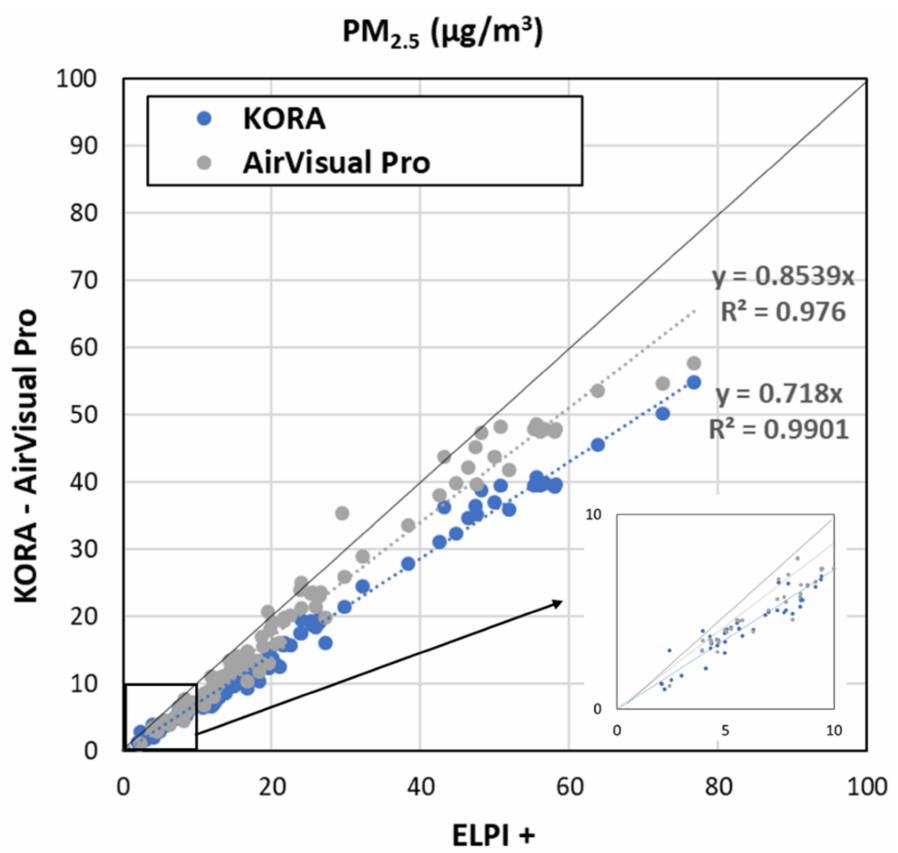
Figure 6. Hourly average concentrations of PM 2.5 measured by KORA (blue circles) and AirVisual Pro (grey circles) with respect to ELPI+. Ideal correlation is shown by the slope 1 line. The inset better evidences the correlation at the lower end of concentration